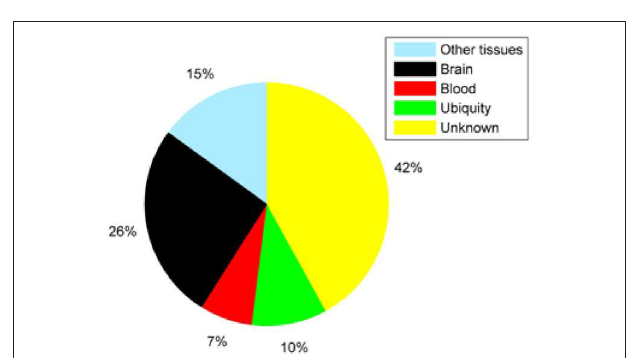
certain value, so there is no box in the box diagram but a line.